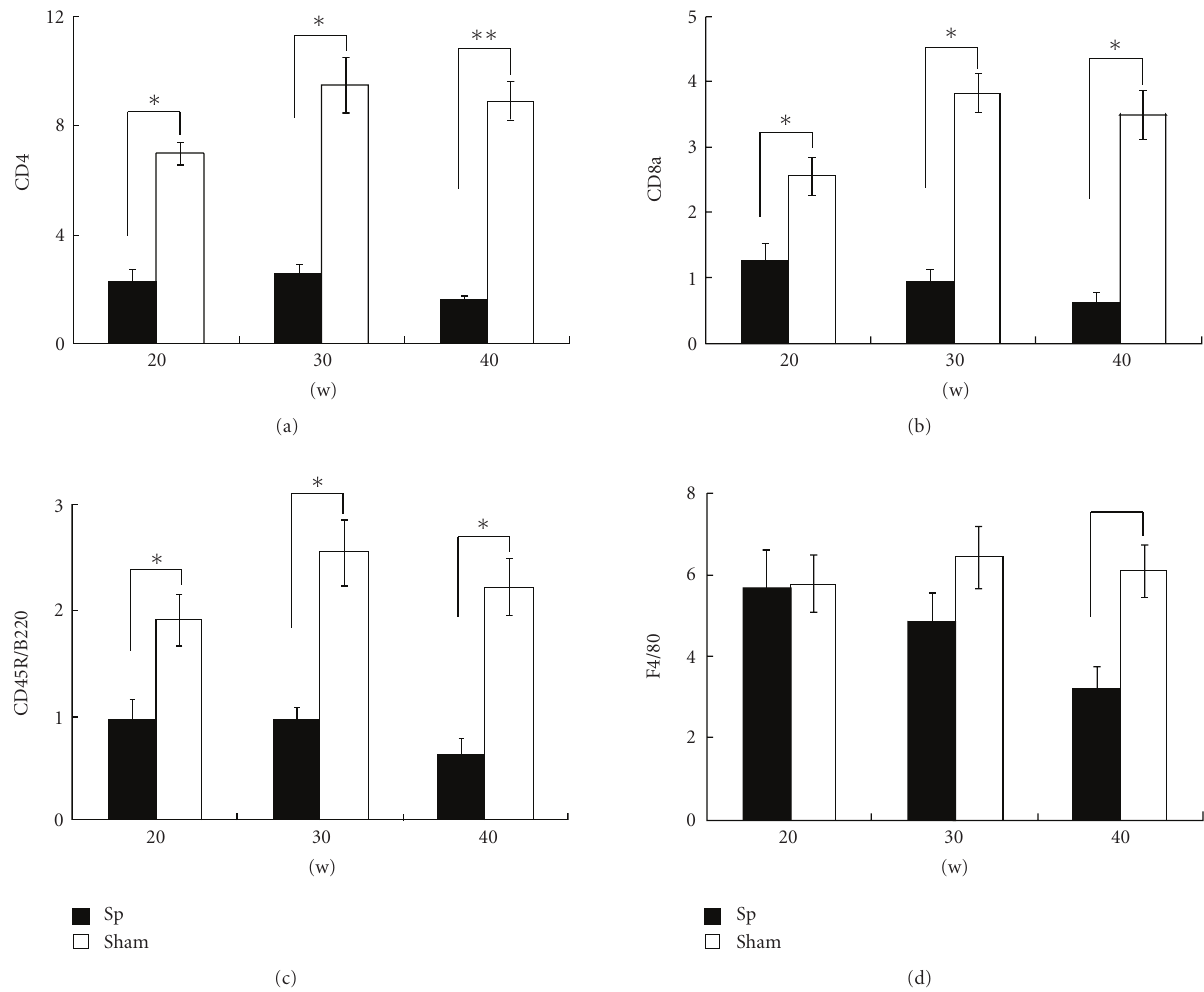
Figure 5: Immunostaining positive scoring of the pancreas was evaluated as a percentage of the total area of the specimen in splenectomized (Sp) and sham aly/aly mice at the ages of 20, 30, and 40 weeks old, respectively. Results are expressed as the mean ± SEM. ∗ P < . 05; ∗∗ P < .